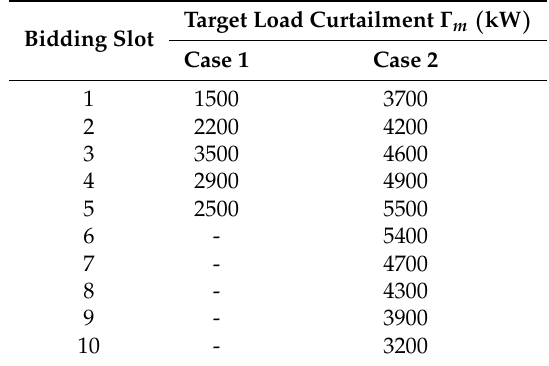
Table 2. Target load curtailment profiles for two cases of demand bidding.